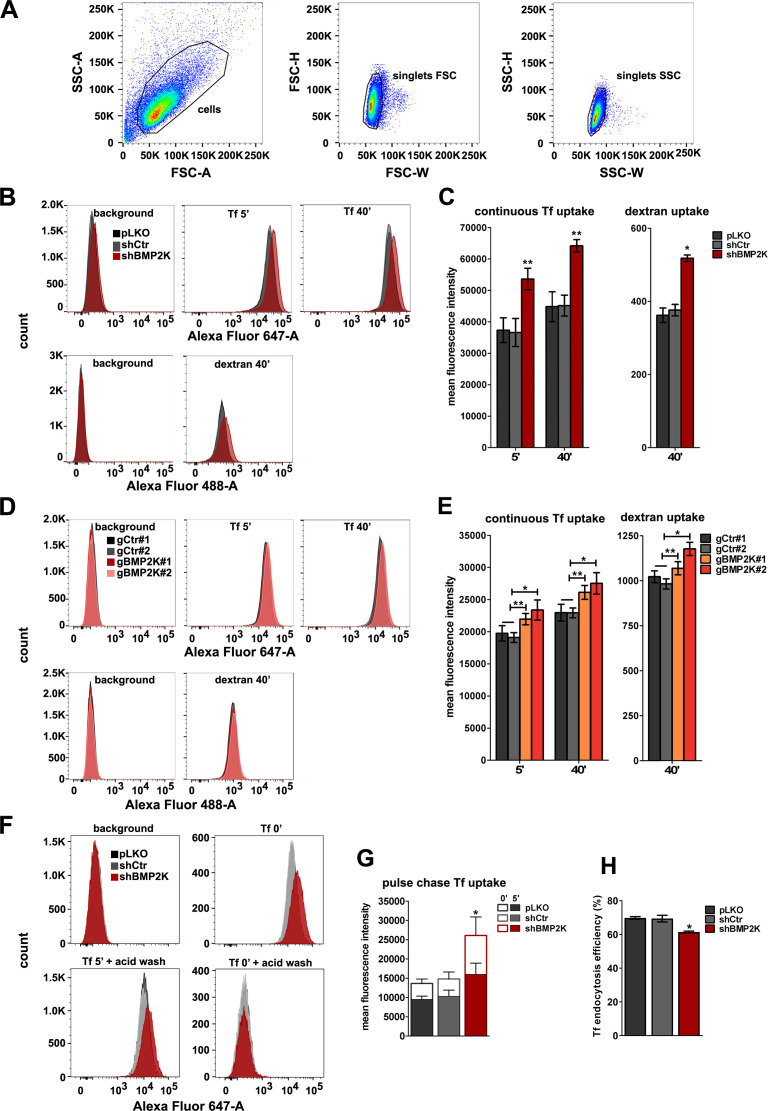
The effects of depleting all BMP2K splicing variants on endocytosis.(A) An example of gating strategy for flow cytometric analyses applied for K562 cells transduced with empty pLKO vector, including cell gate (FSC vs SSC) and singlet discrimination gates (FSC-H vs FSC-W, SSC-H vs SSC-W). This strategy was applied for all flow cytometry experiments. (B and D) Overlay histograms showing fluorescence signal of AlexaFluor647 or AlexaFluor488, indicating Tf or dextran abundance, respectively, in control cells or cells depleted of BMP2K gene products using shRNA (B) or CRISPR/Cas9 (D) approach. Control constructs used were: empty pLKO vector and non-targeting shRNA, shCtr (B) or non-targeting gRNAs, gCtr#1 and #2 (D). (C and E) Flow cytometry analysis of AlexaFluor647-Transferrin (Tf) or AlexaFluor488-dextran levels in control K562 cells or cells depleted of all BMP2K splicing variants using shRNA (C) or CRISPR/Cas9 (E) approach, after allowing for continuous Tf endocytosis at 37°C for 5' or 40', or after 40' incubation with dextran at 37°C (n = 3 or 4 in C and 4 in E +/- SEM). (F) Overlay histograms showing fluorescence signal of AlexaFluor647, indicating Tf abundance during pulse-chase endocytosis assay in control cells or cells depleted of all BMP2K splicing variants using shRNA. (G, H) Pulse chase Tf uptake in cells with depletion of all BMP2K splicing variants using shRNA. (G) The empty bars represent the amount of fluorescently-labelled Tf pre-bound to cells while the solid bars show the amount of Tf internalized at 37°C for 5’ (n = 3 +/- SEM). (H) The percentage of internalized Tf with respect to the amount of pre-bound Tf (n = 3 +/- SEM). The histograms (B, D and F) illustrate representative experiments included in the analyses shown in C, E, G and H. Values obtained for BMP2K-depleted cells were compared statistically to those in shCtr-treated cells (C, G and H) or to the average of values measured for gCtr#1 and gCtr#2-transduced cells (E). *p<0.05, **p<0.01.Figure 1—figure supplement 3—source data 1.Numerical data for graphs in Figure 1—figure supplement 3.